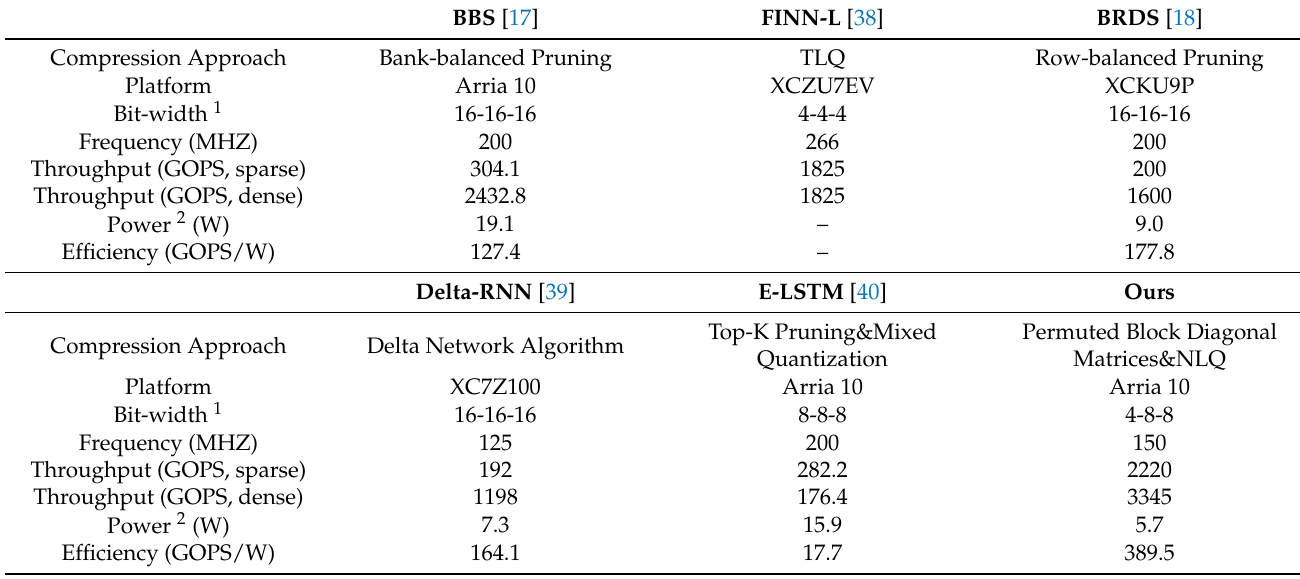
Table 6. Comparison with Other FPGA-Based Long Short-Term Memory (LSTM) Accelerators. BBS [17] FINN-L [38] BRDS